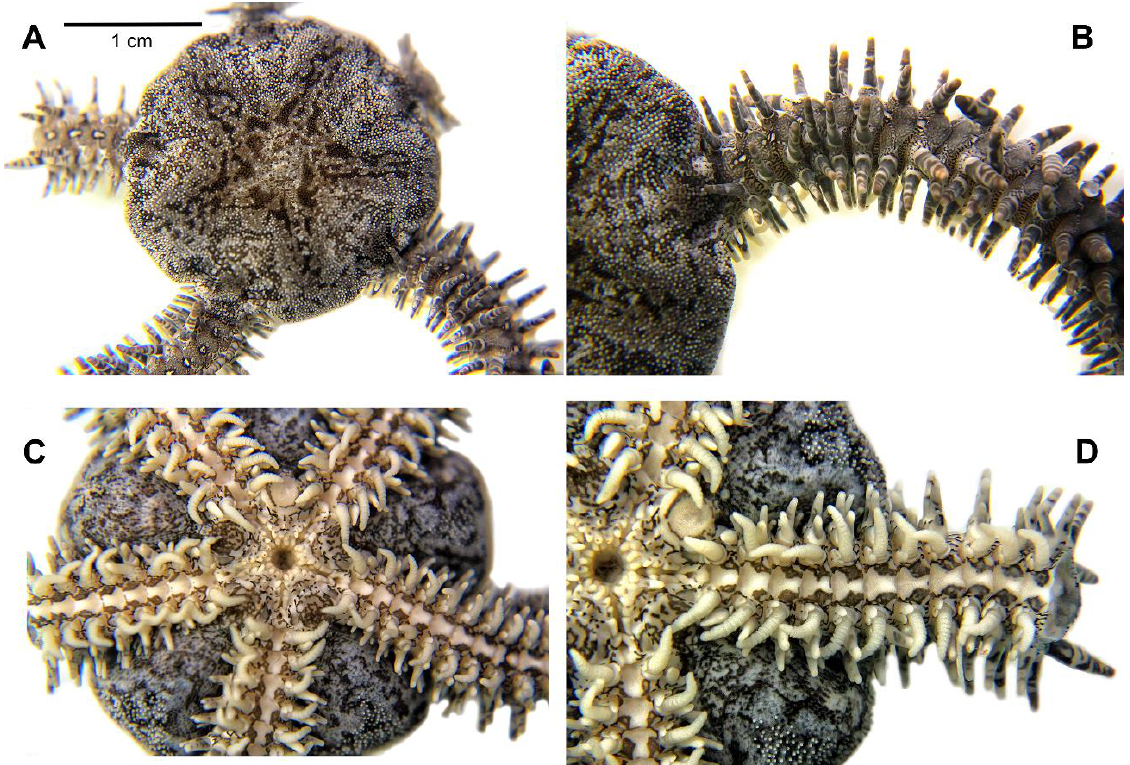
Figure 4 . Ophiocoma scolopendrina dorsal (A & B) and ventral view (C & D), collected at Bostaneh.